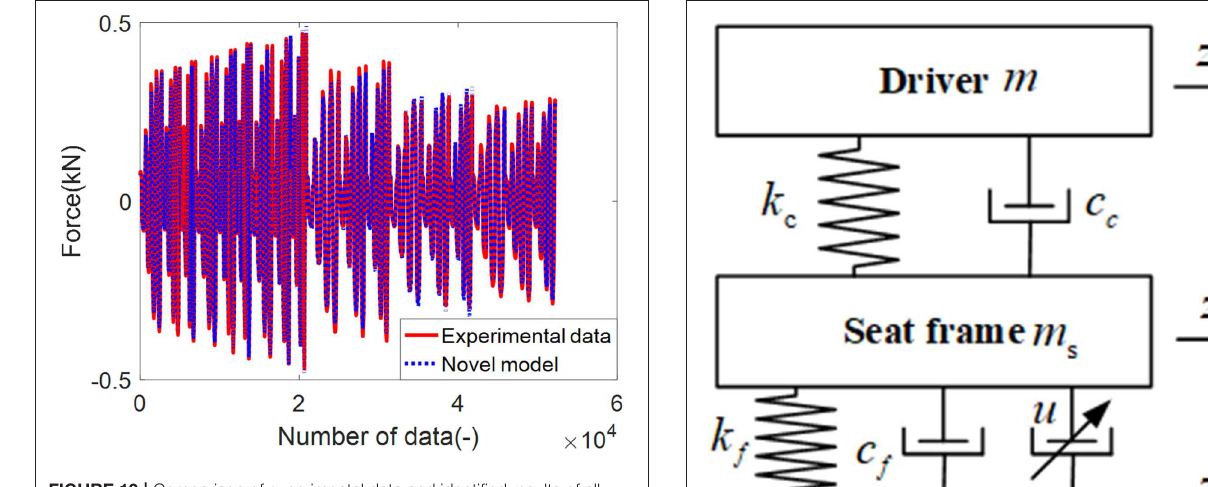
FIGURE 10 | Comparison of experimental data and identified results of all data.